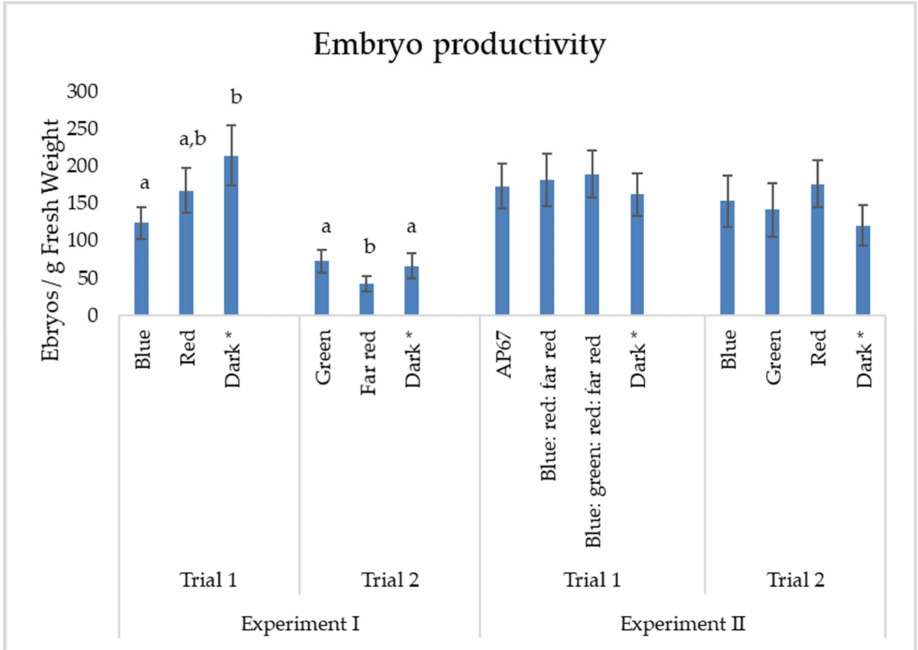
Figure 4. Norway spruce somatic embryo production capacity in Experiment I, in which ET was proliferated under different light spectra, and then the embryos were matured in the dark. In Experiment II, developing embryos from ET proliferated in the dark were kept under different light spectra for 29 days at the end of maturation. The mean values are presented with standard error bars. Significant differences within each trial are marked with differing letters. The asterisk (*) in different experiments represents the same control treatment in which the ET was proliferated, and somatic embryos were matured in the dark. The 95% confidence level was used. The differences in embryo productivity between SE lines are illustrated in Supplementary Figure